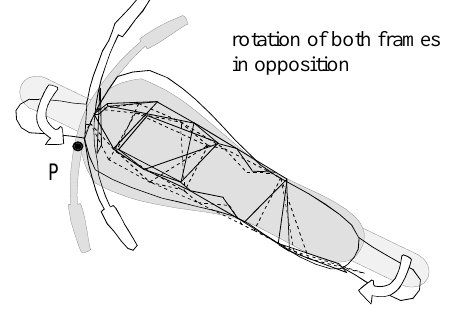
Fig. 7. Vehicle A, TDM, frequency 17.9 Hz, hysteretic damping 8.4%.